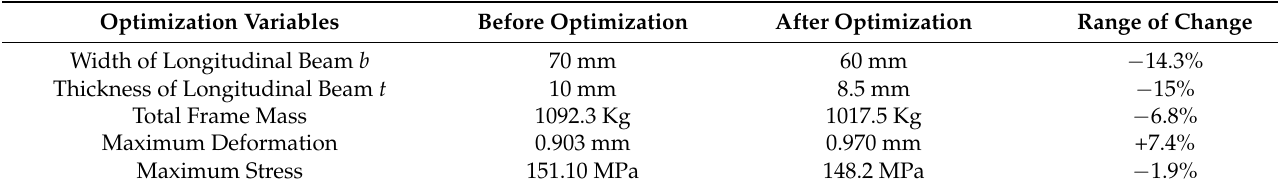
Table 6. Initial values of optimization variables and optimization